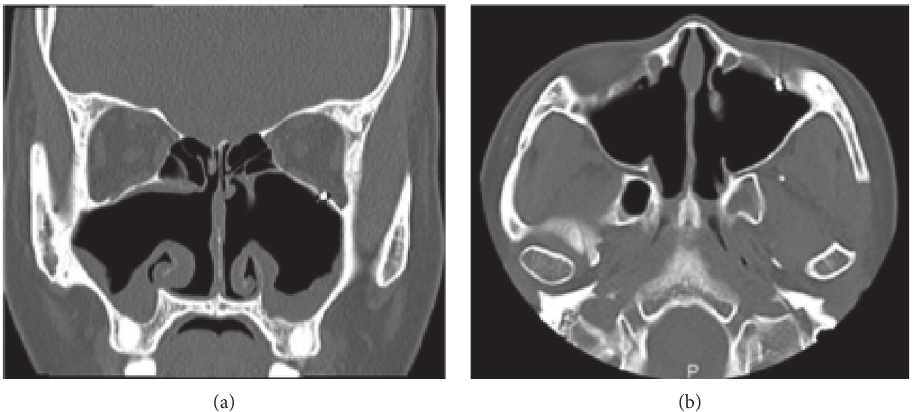
Figure 5: Computed tomography (CT) image (postoperation). Postoperative (a) coronal and (b) axial CT scans show the both sides of nasolacrimal duct and inferior turbinate were preserved. Also, the coil in the left infraorbital artery was seen in infraorbital